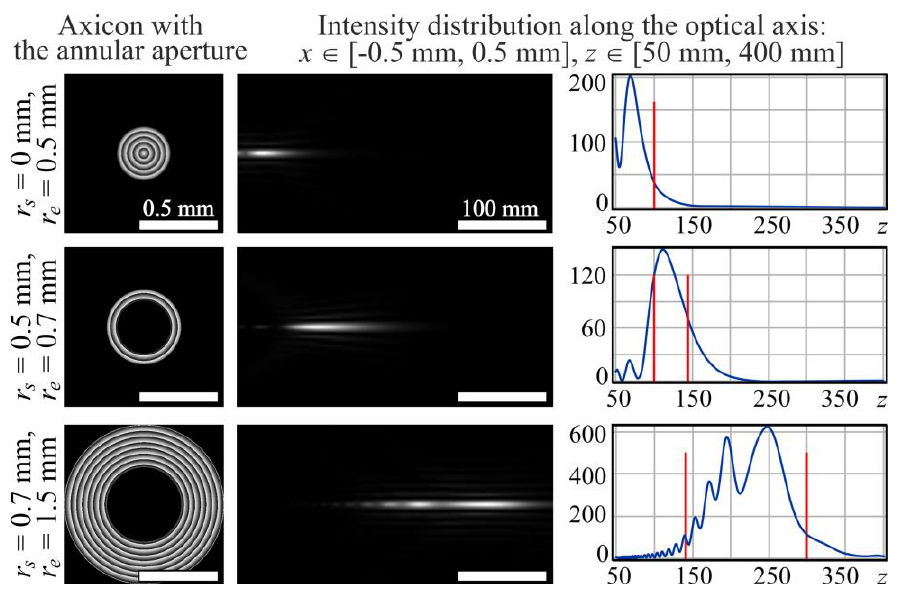
Figure 2. Simulation results of the formation of axial light segments with different lengths and positions due to variations in the parameters of the annular aperture were obtained using Equation